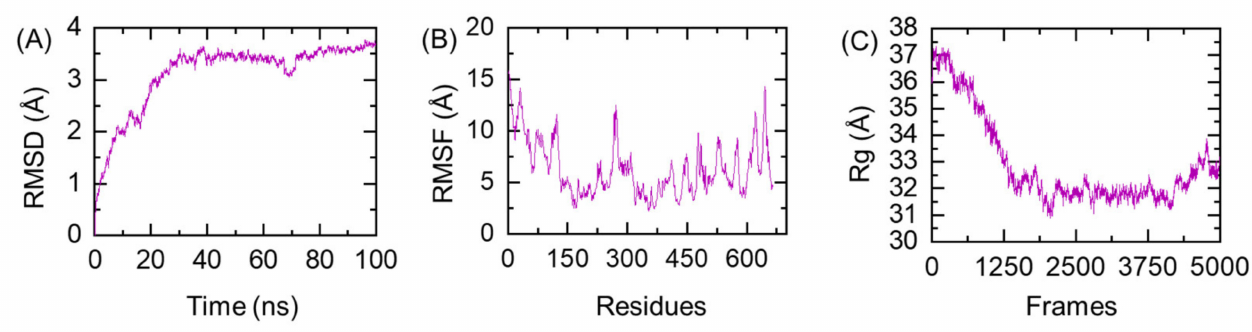
Figure 6. Stability, compactness and flexibility evaluation of the MEVC. ( A ) shows the RMSD, ( B ) represents the compactness (Rg), while ( C ) shows the residual flexibility as